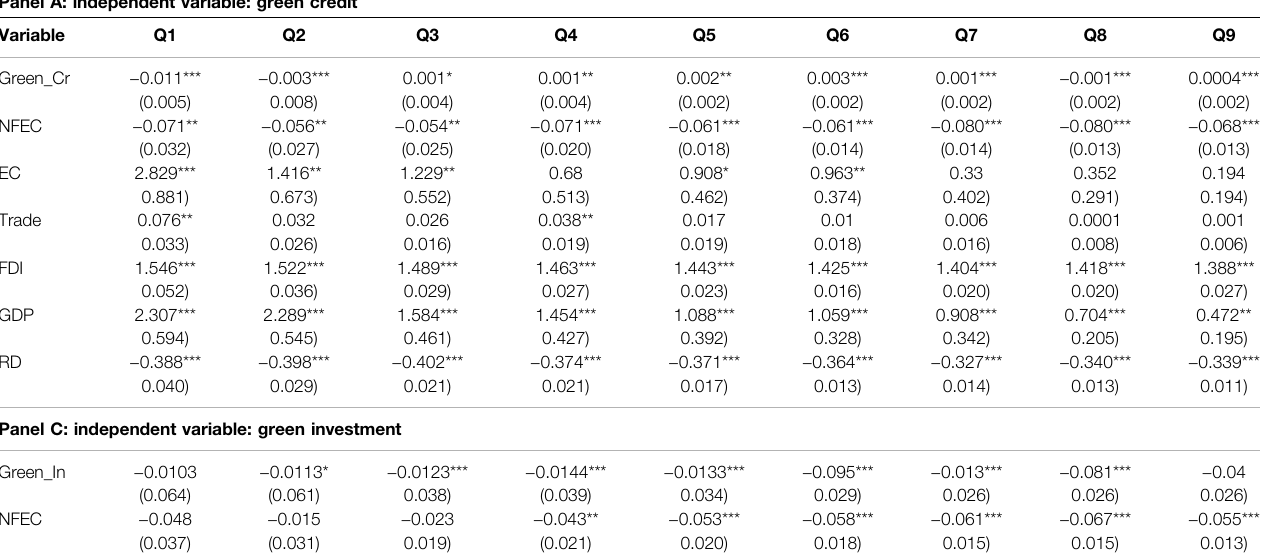
TABLE 7 | Robust analysis using the original variables green credit, green investment, and green securities. Panel A: independent variable: green